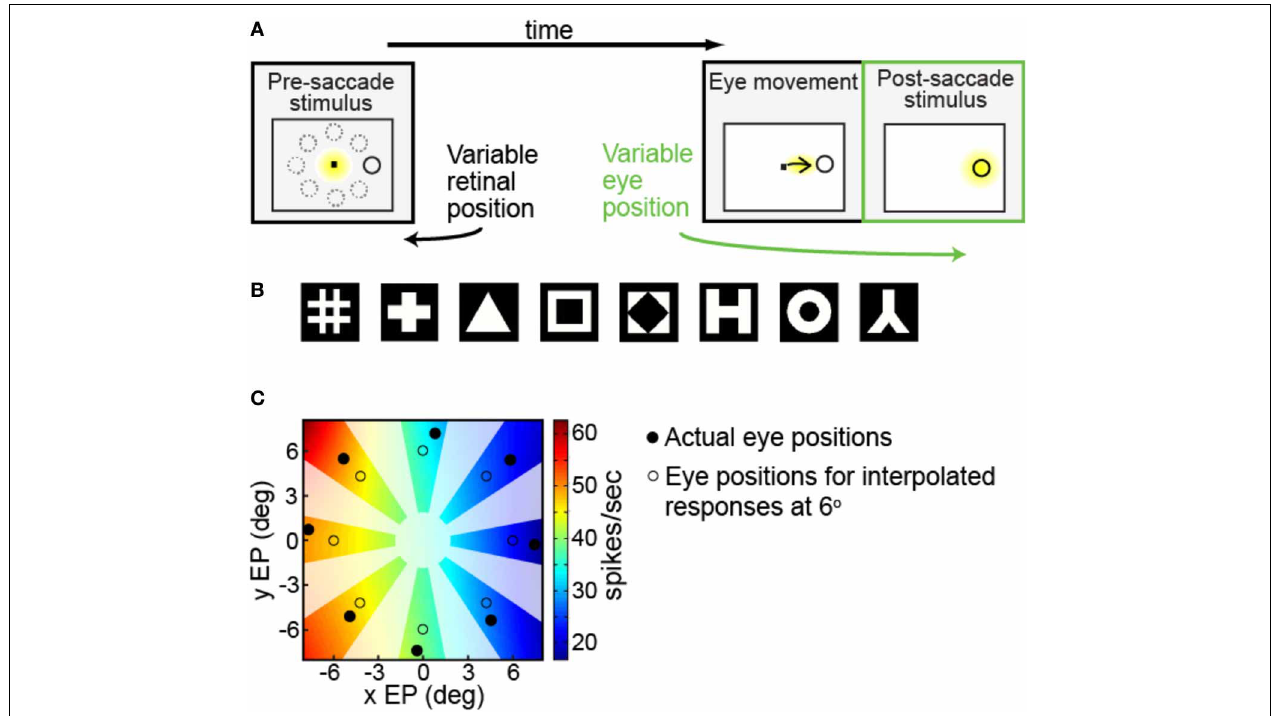
FIGURE 1 | Experimental and data analysis methods. (A) Task design, showing sequence of events in a single trial. Yellow indicates where the monkey was fixating at each phase of the trial. After the monkey was stably fixating, the stimulus shape appeared randomly at one of eight peripheral locations (first panel). Dotted circles show possible target locations. The monkey immediately made a saccade to the stimulus (second panel). After the saccade (third panel, marked in green) the monkey was stably fixating the target (indicated by the yellow highlight) at some gaze angle. On different trials the target location randomly changed, so we could measure response to the same target stimulus for different eye positions. (B) Set of possible stimulus shapes. Preliminary testing of each cell indicated which of these eight shapes was the most effective stimulus for that cell, which was then used for subsequent measurements of eye-position modulations. (C) Example of interpolated/extrapolated